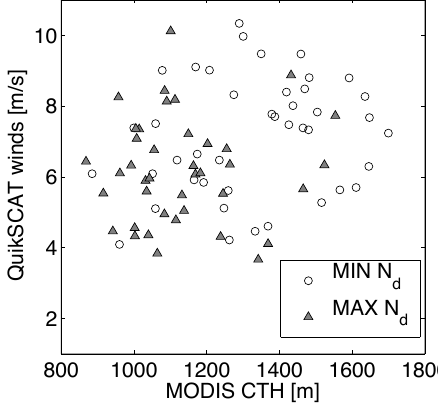
Figure 4. Scatterplot between Terra daytime MODIS-derived cloud top height and Fig. 4. Scatterplot between Terra daytime MODIS-derived cloud evening-pass QuikSCAT winds, taken from Fig. 4. Open circles and filled triangles top height and evening-pass QuikSCAT winds, taken from Fig. 4. correspond to MIN and MAX N d days respectively. Open circles and filled triangles correspond to MIN and MAX N d days